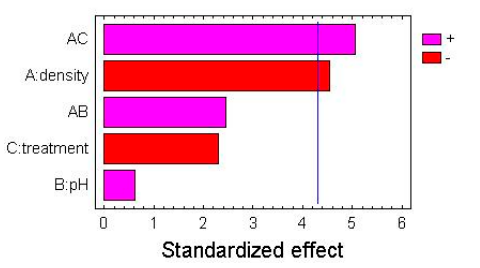
Figure 3. Standardized Pareto Chart for percentage variation of strain.